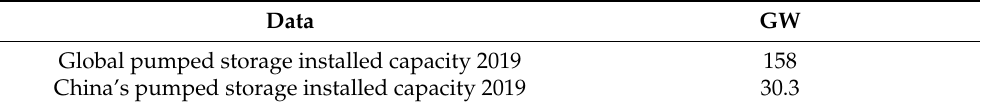
Table 2. Pumped storage installed capacity at global and Chinese